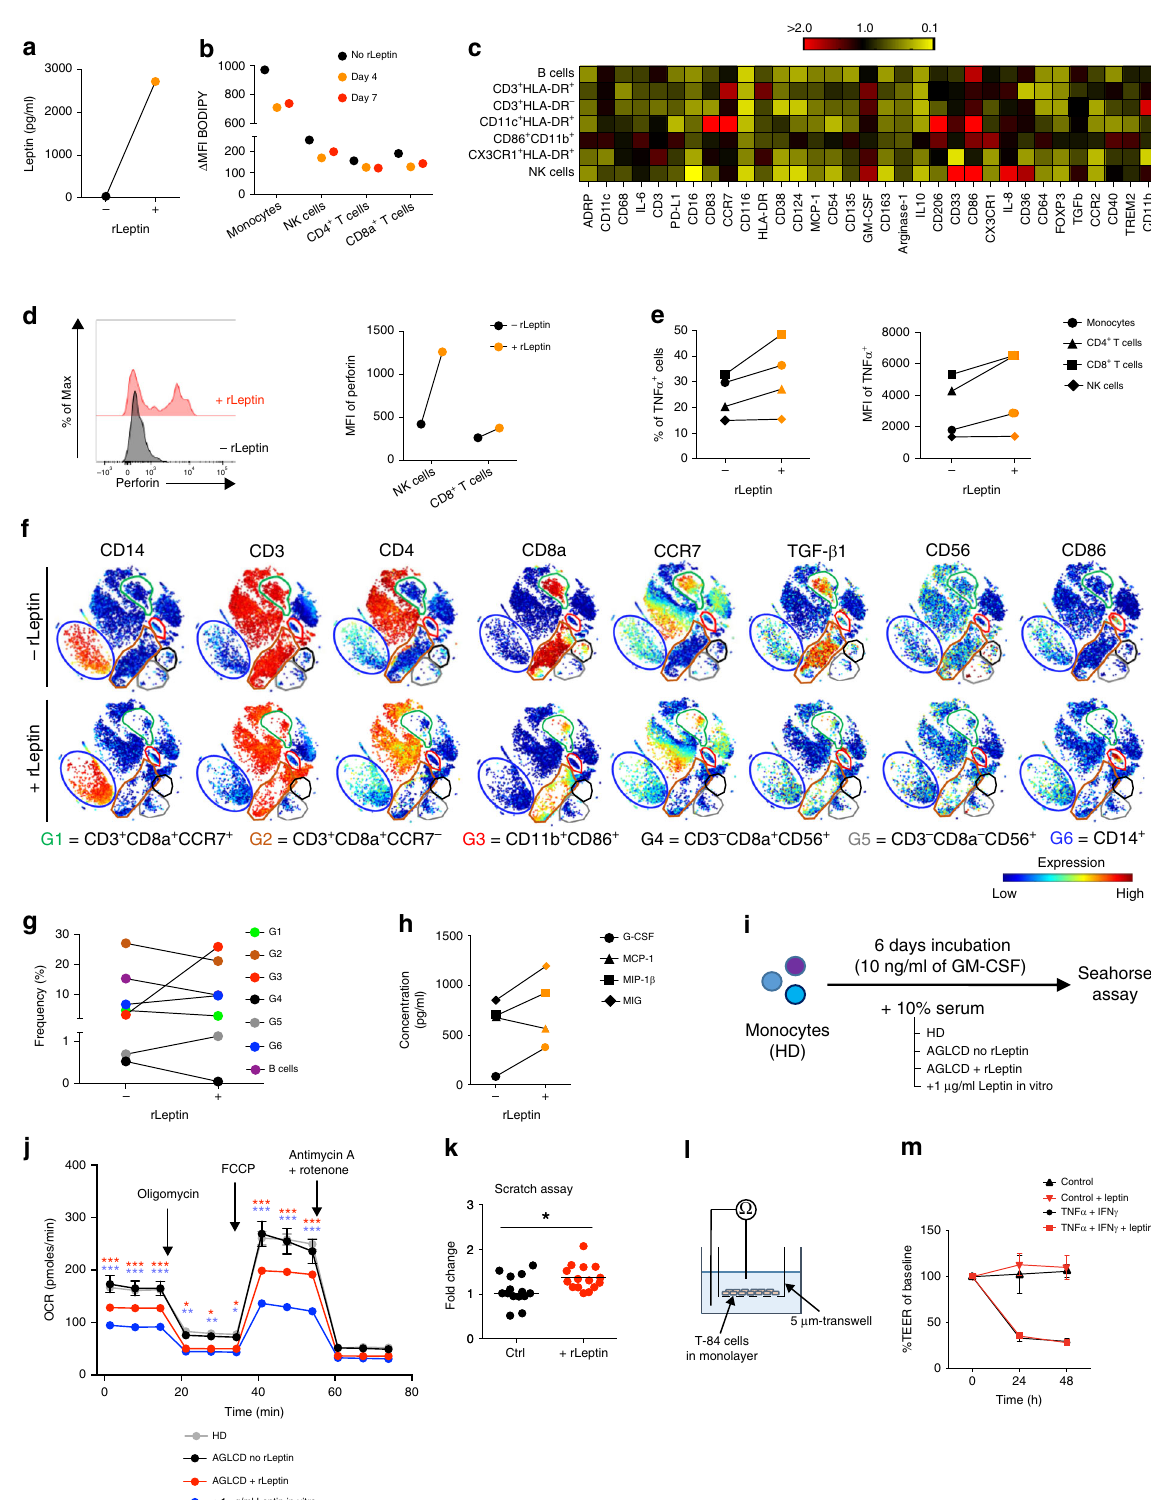
in particular fi stula development, resulted in an abscess that healing capacity and epithelial resistance of human intestinal ultimately led to ileocolonic resection and terminal ileostomy epithelial cells in vitro. As shown in Fig. 3k leptin administration (Figs. 1d and 4a). Severe in fl ammation was detected in all resected improved wound closure in vitro in scratch assays with T84 cells, intestinal segments (Fig. 4b). Results from immunohistochem- without altering epithelial resistance (Fig. 3l, m). istry (Supplementary Table 4) showed a massive in fi ltration of Intestinal in fl ammation under rLeptin substitution . The high the intestinal mucosa with TNF α -expressing cells within the lamina propria of the AGLCD patient when compared to CD disease activity of CD observed in our AGLCD patient during patients (Fig. 4c). In line with our mass cytometry data, we rLeptin substitution and previously developed structural damage, NATURE COMMUNICATIONS| (2019) 10:5629